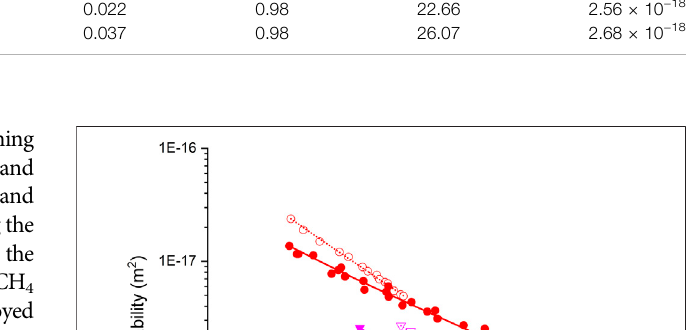
κ fi tting and e 0 and 0 used for